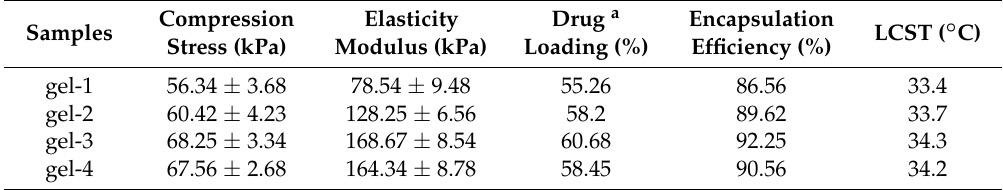
Table 2. The compressive properties and drug-loading and encapsulation efficiency of hydrogels.